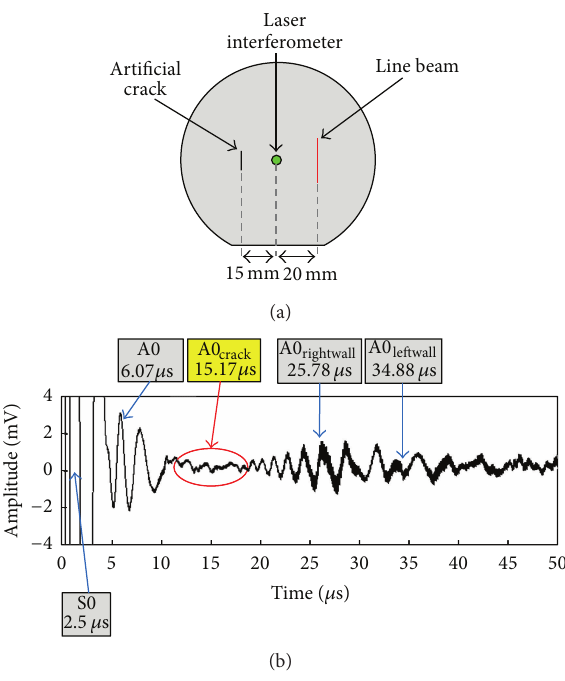
Figure 9: (a) Experimental setup and (b) received